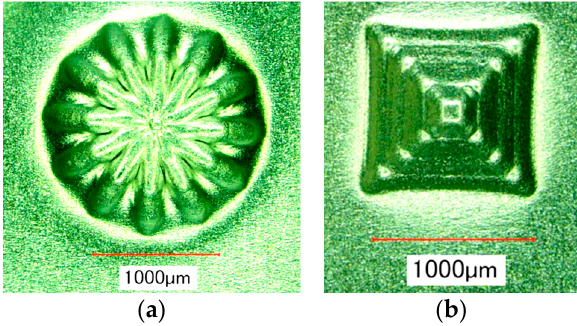
Figure 11. Other pyramids formed by ultrasonic incremental microforming: ( a ) pyramid like sunflower; ( b ) stepwise pyramid.